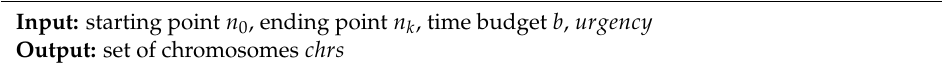
Algorithm 1: encoding ( n 0 , n k , b , urgency